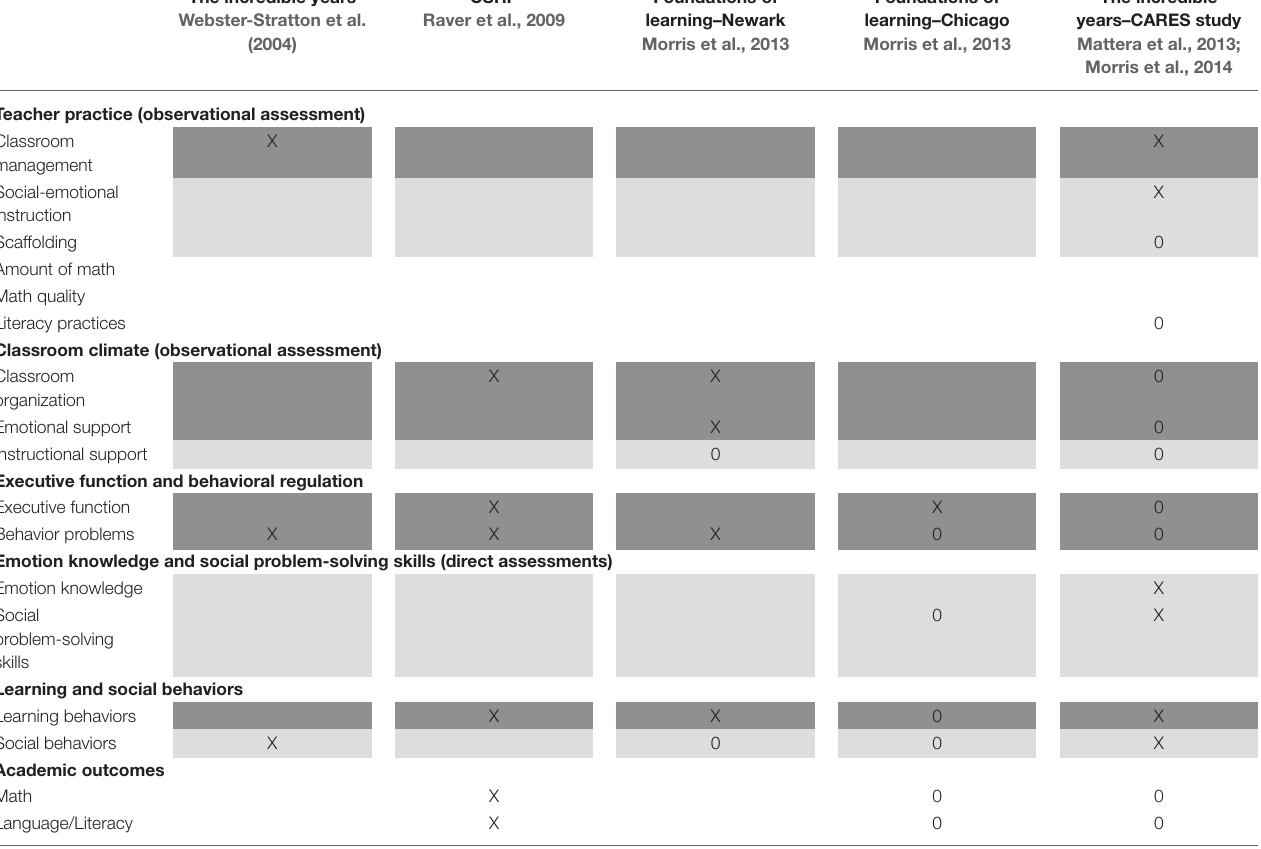
TABLE 5 | The pattern of effects on teacher and child outcomes for behavioral-focused interventions. The incredible years Webster-Stratton et